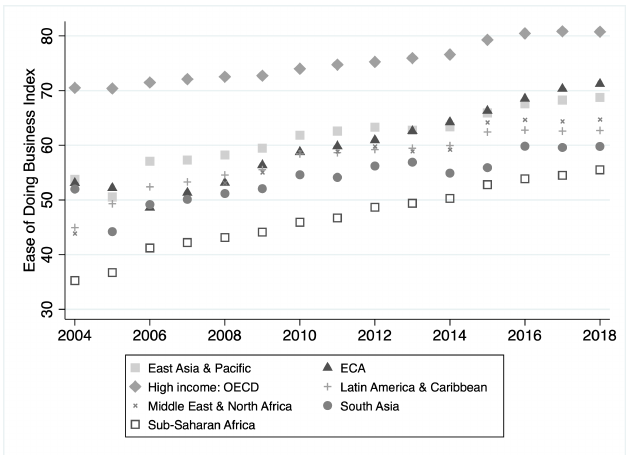
Figure B.1: Economics Freedom Index